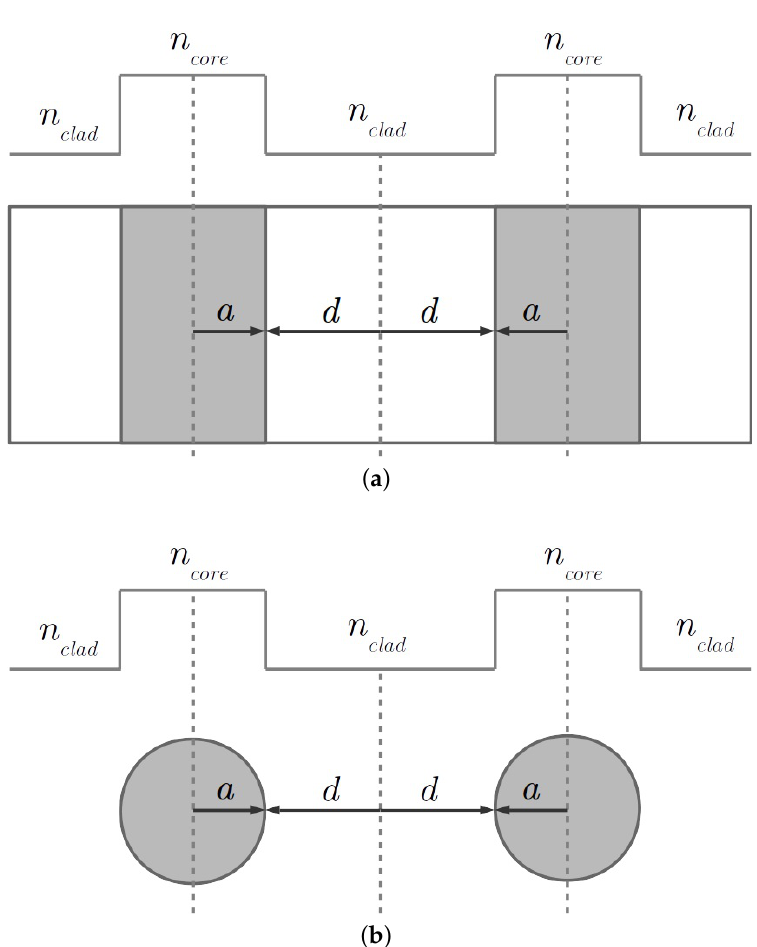
Figure 1. The refractive index profiles of the double guided structures used in this work. Here, the distance between the guides is given as 2 d , whilst a is used both for the half-width of a slab guide and the radius of a circular guide. Elsewhere in this work, we use n 1 = n core and n 2 = n clad for brevity. ( a ) Slab waveguide. ( b ) Circular waveguide.